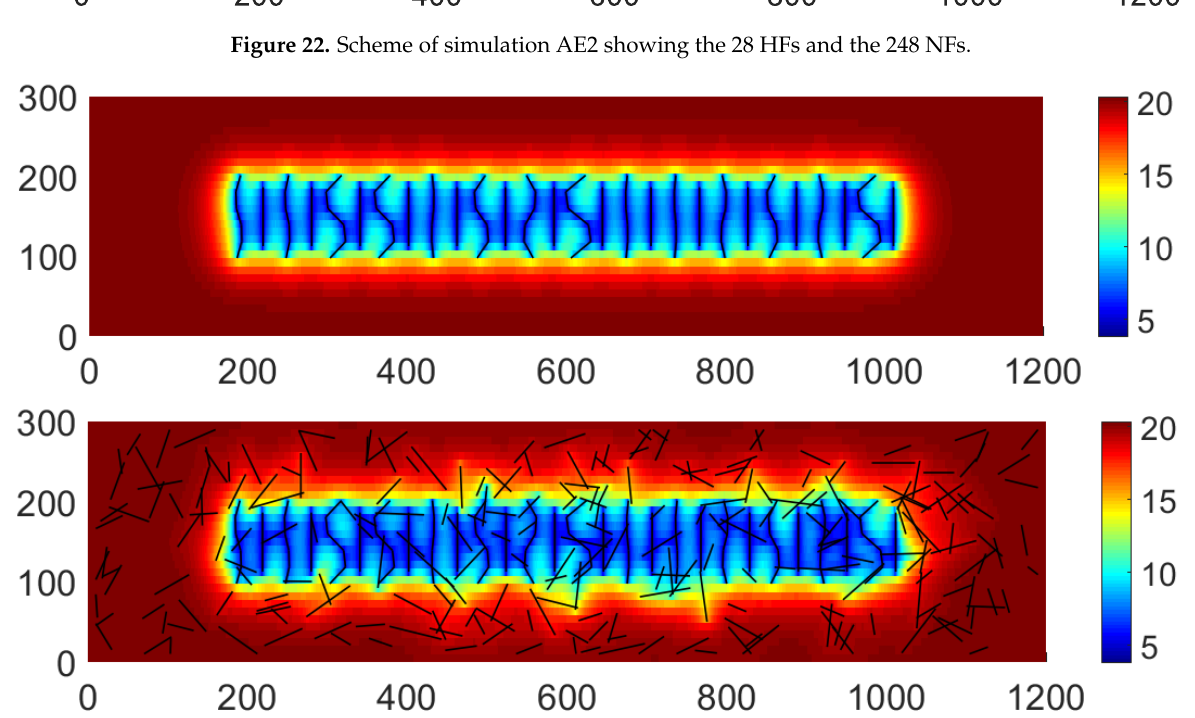
Figure 23. Pressure contours at 3.75 years for the Barnett shale reservoir (simulation AE2) for the scenario with curvilinear HFs ( top ) and for the scenario with the DFN added ( bottom